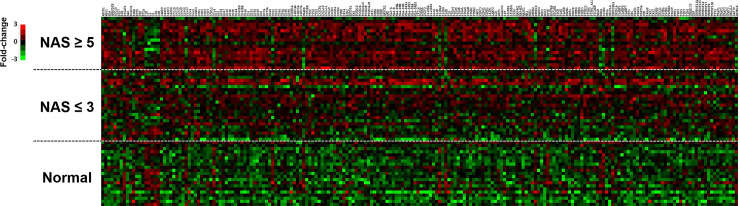
Differential hepatic gene expression in NAFLD progression.Heat map representing color-coded expression levels of differentially expressed genes (FDR<0.01, p<0.01) for each individual sample across the three cohorts (normal, NAS ≤3, and NAS ≥5). A total of 211 genes are included in the heatmap. Z-score transformation was performed with Euclidean distance metric and average expression linkage for bottom-up hierarchical agglomerative clustering using nSolver® Analysis Software v2.6. Red indicates increased relative expression and green decreased relative expression.